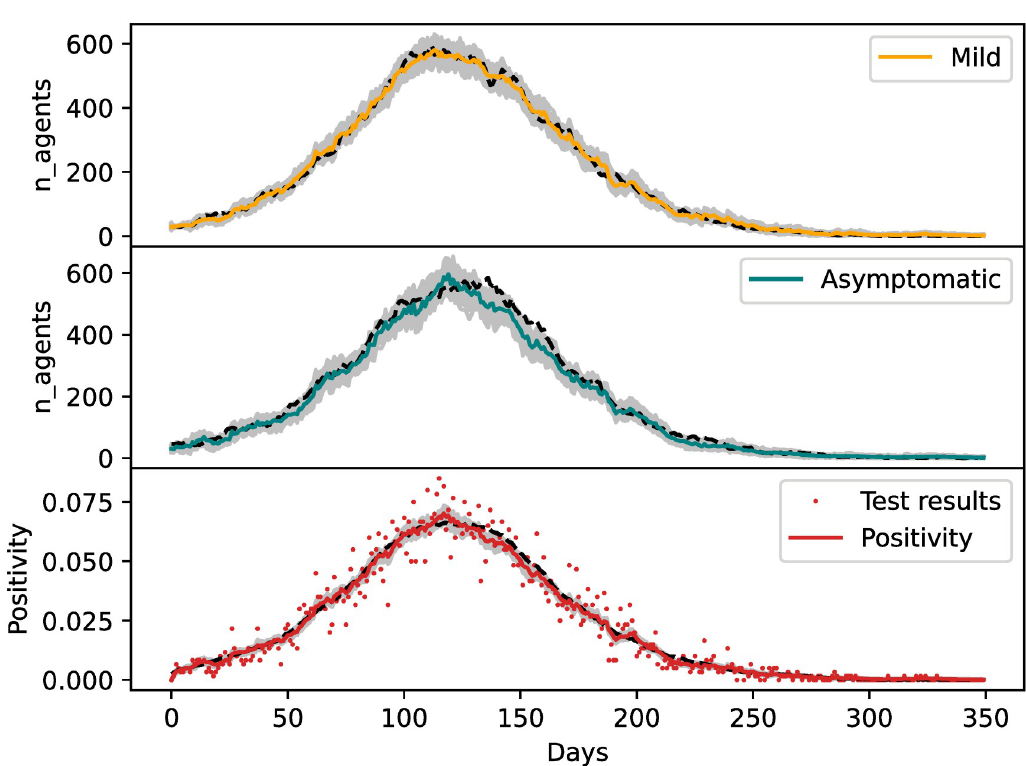
Fig 8. Estimations of active reported mild cases, unreported cases and positivity. Top panel: evolution of reported active mild cases. Orange solid line is the ensemble mean. Middle panel: Unreported active cases. Teal solid line is the ensemble mean. Bottom panel: Positivity (percentage of agents that would test positive). Red solid line is the ensemble mean. Dots correspond to the testing data generated with the true run. For every panel, gray lines indicate ensemble members and dashed lines the true value of the corresponding